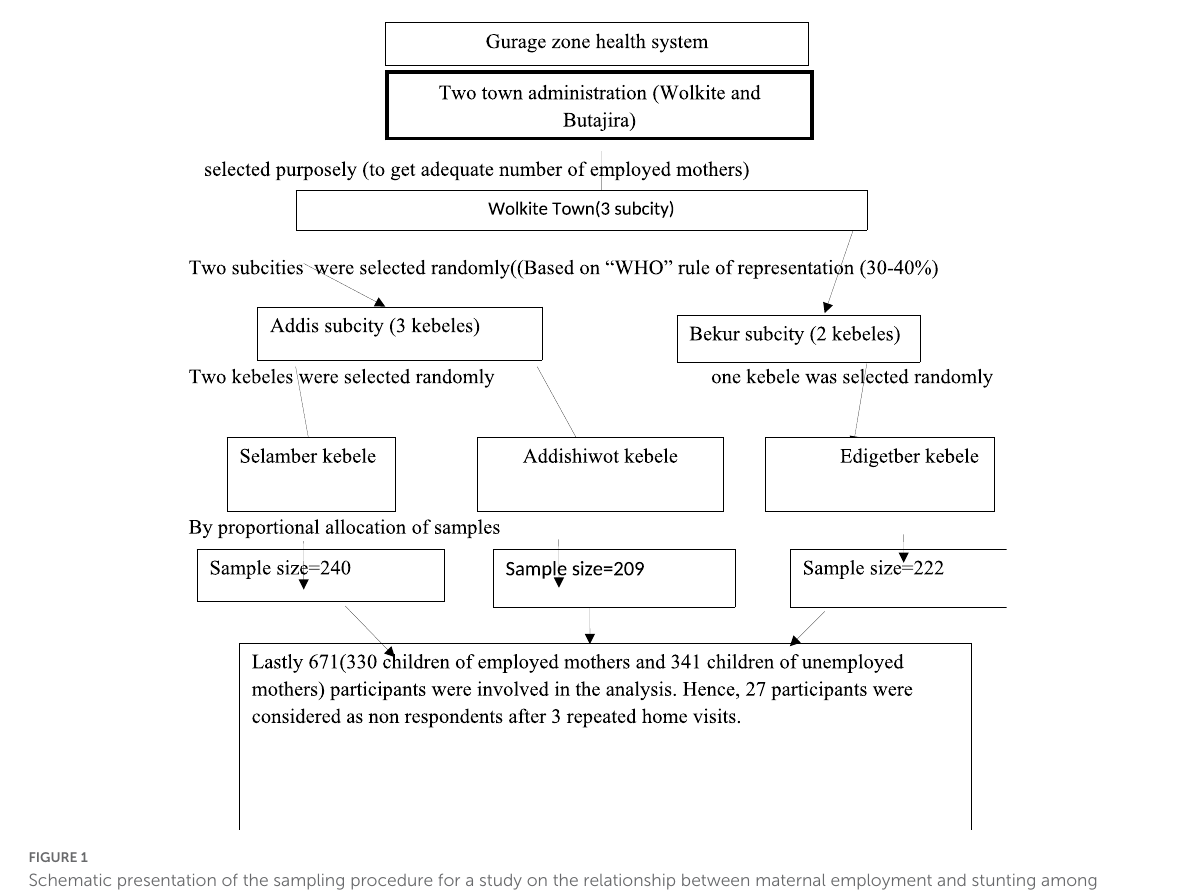
was further allocated proportionally to each randomly selected kebele. A total of 3 kebele were included [Based on the “WHO” rule of representation (30–40%)] (see Figure 1